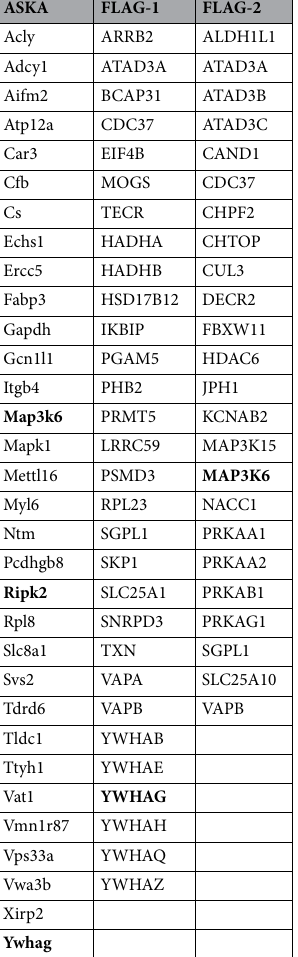
Table 1. List of the ASK1-interacting candidates. The ASK1 interactor candidates from ASKA pull-down MS for as-ASK1 derived from primary brown adipocytes in Ask1 ASKA knock-in mice (ASKA), Flag-tag pull-down MS for Flag-ASK1 derived from overexpressed HEK293A cells 27 (FLAG-1) and Flag-tag pull-down MS for ASK1-HA-Flag derived from overexpressed HEK293 cells 28 (FLAG-2). Each pull-down identified 32, 30 and 24 interactor candidates, respectively. Proteins highlighted in bold are the molecules mentioned in the main text. See Fig.